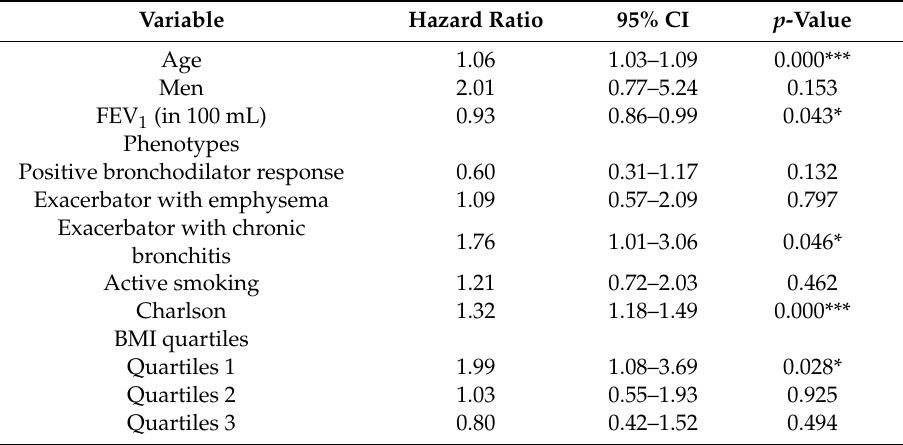
Table 6. Risk factors independently associated with